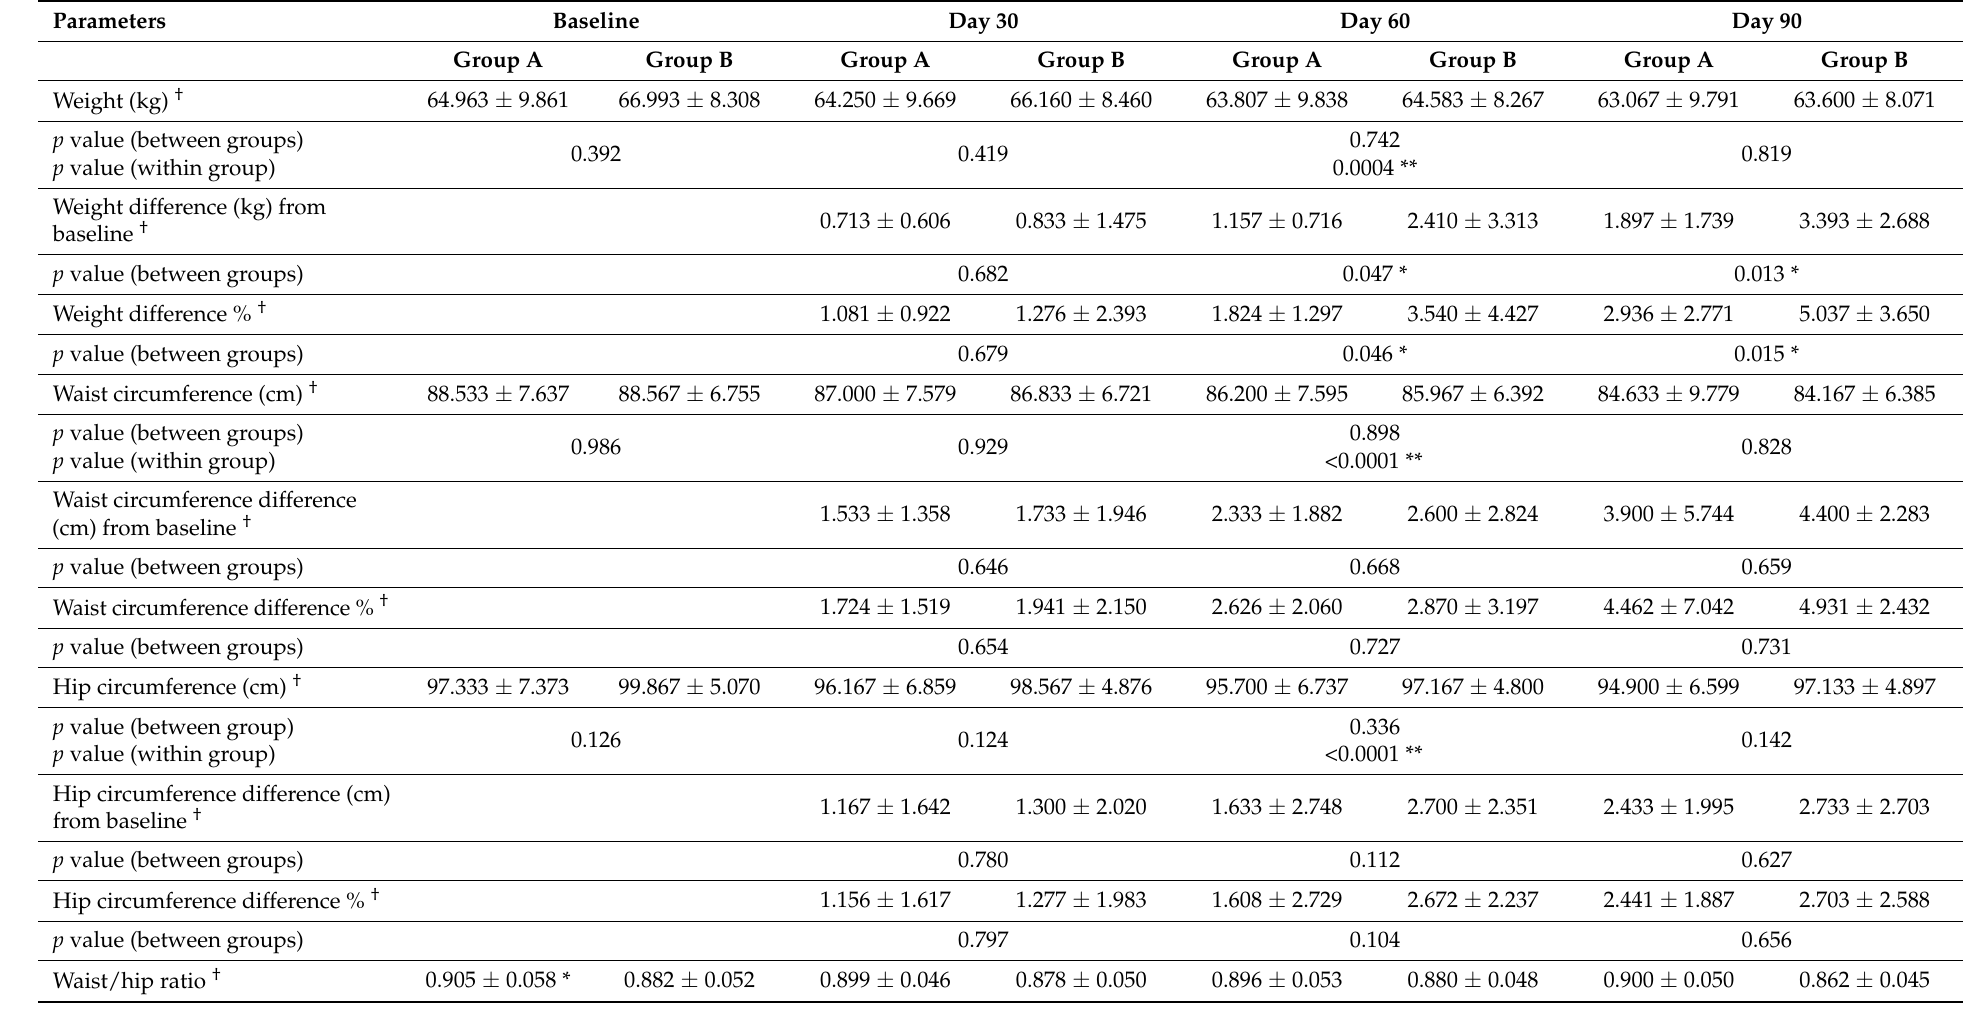
Table 3. Change in weight (kg), waist circumference (cm), hip circumference (cm), waist/hip ratio, and body mass index between